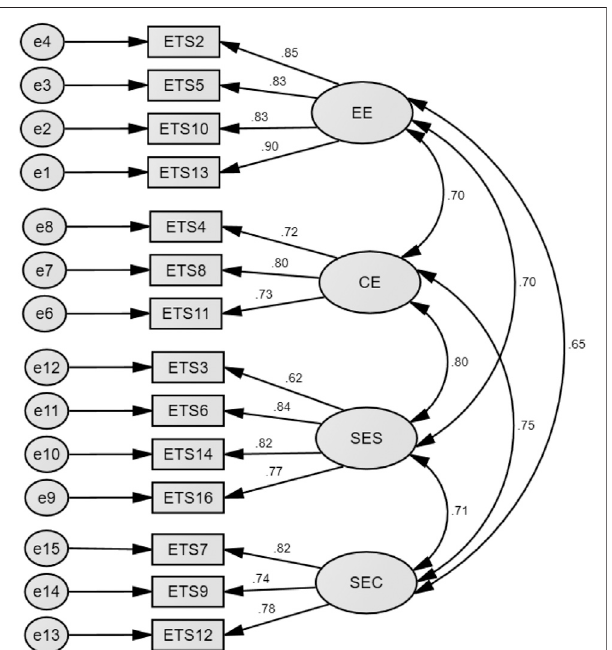
FIGURE 4 | A higher order con fi rmatory factor analysis for the 14-item model of the